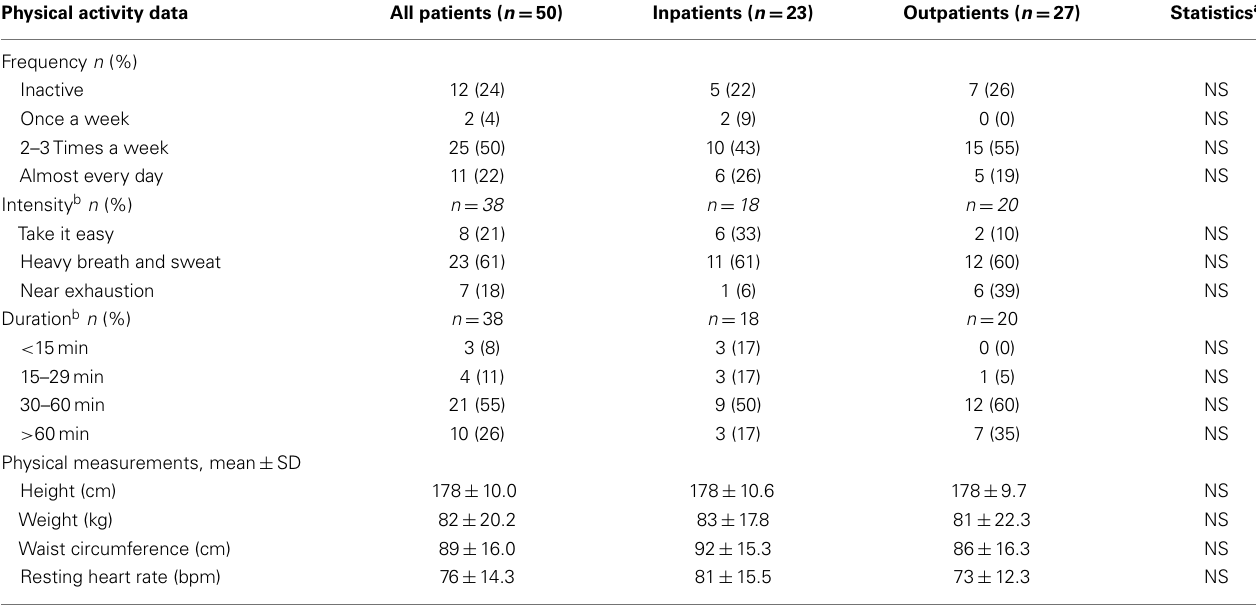
Table 2 | Physical activity data and measurements for 50 patients with severe mental disorders